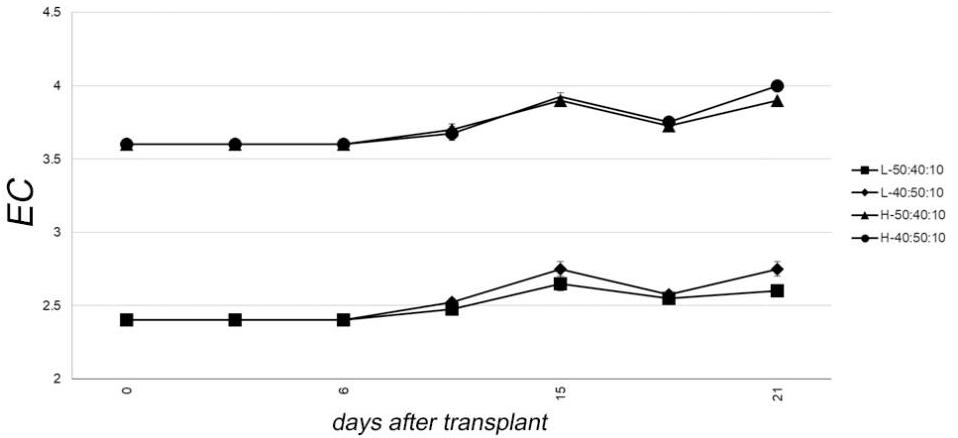
Figure 3. Mean weakly EC levels during the cultivation period. Vertical bars denote ± standard errors of means (n = 4).